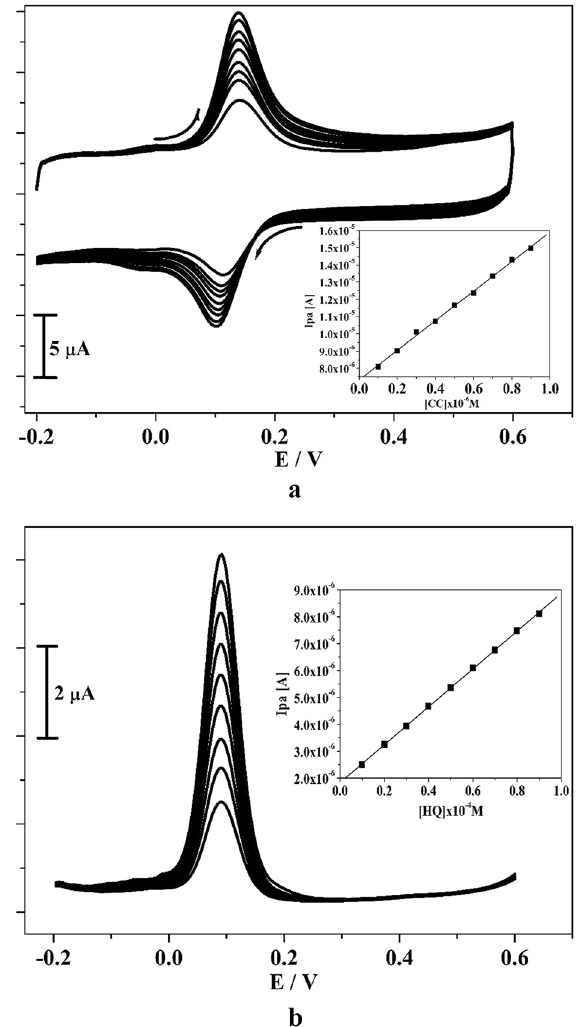
Figure 7. ( a ) CVs curve for CC at poly(CBBG)/MCPE with various concentration (10–90 µM) in presence 0.2 M PBS (pH 7.4) with scan rate of 50 mVs -1 and inset figure is plot of Ipa versus CC concentration. ( b ) DPVs for altered concentration of CC (10–90 µM) at poly(CBBG)/MCPE and inset figure is plot of Ipa against CC